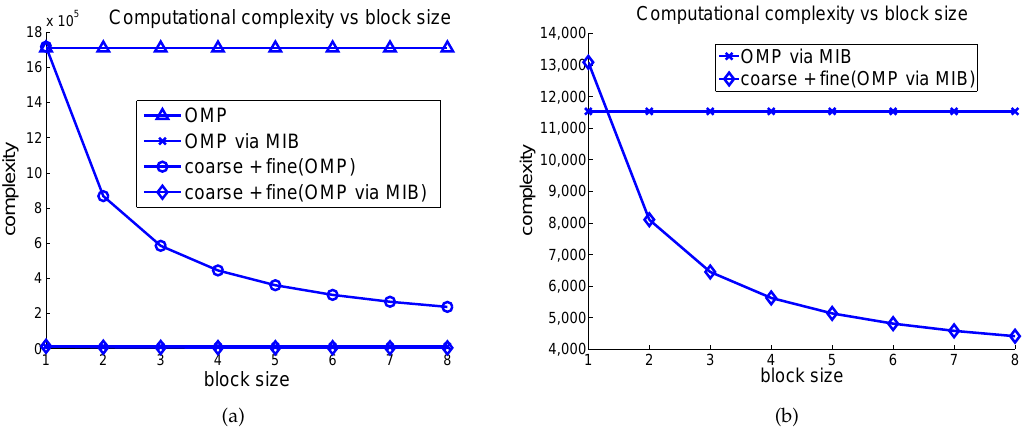
Figure 6. Computational complexity versus block size where m = 512, and n =